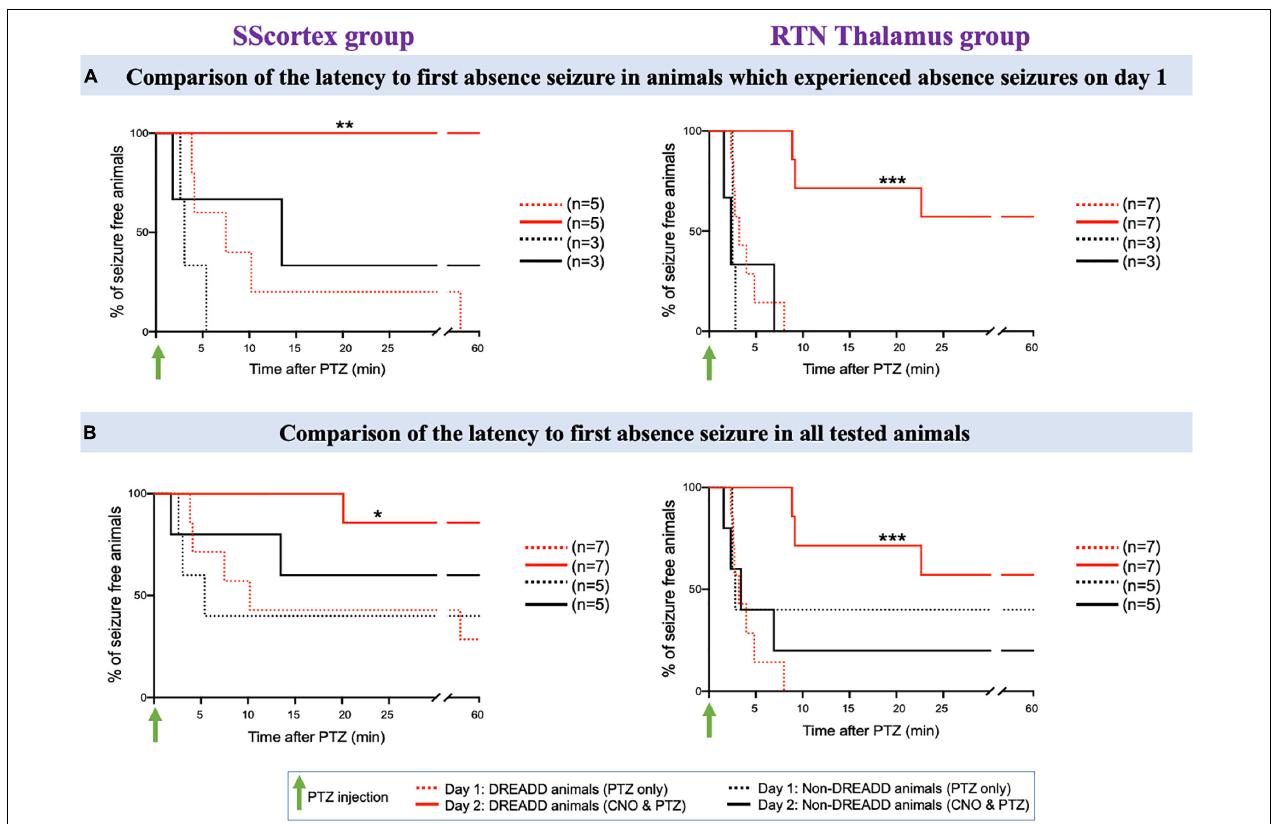
FIGURE 8 | (A) Comparison of the latency to first absence seizure in animals which experienced absence seizures on day 1. (B) Comparison of the latency to first absence seizure in all tested PV Cre /Gq-DREADD and non-DREADD WT controls of the SScortex group and the RTN thalamus group between day 1 (PTZ only treated) and day 2 (CNO and PTZ treated). Comparisons between the treatment groups were made using log-rank test. (A) ** p = 0.0024, *** p = 0.0002; (B) * p = 0.0268, *** p = 0.0001.